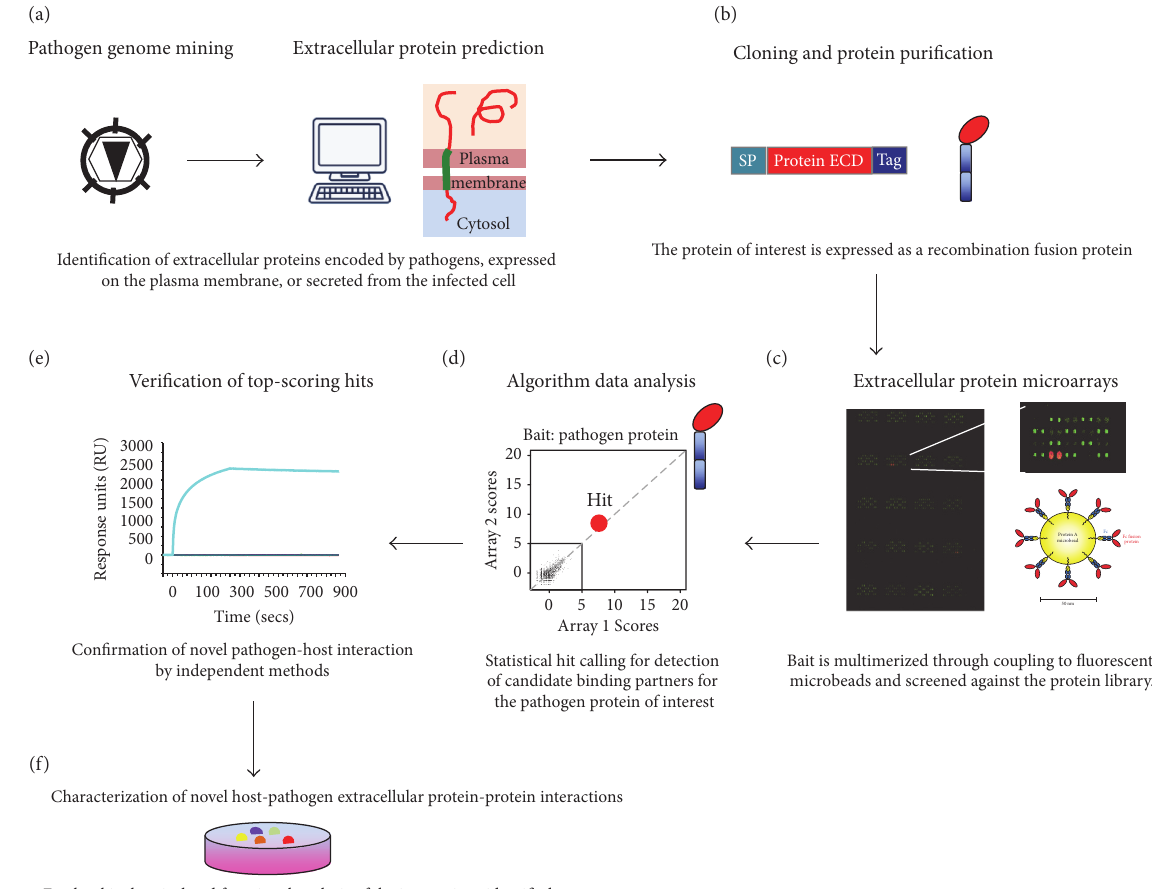
Figure 1: Overview of the application of the protein microarrays technology for extracellular pathogen-host protein-protein interaction discovery. (a) Identification of genes that encode for secreted factors or cell surface-expressed proteins, based on published data or bioinformatics analysis. (b) Cloning, expression, and purification of the pathogen-encoded proteins of interest. The full-length protein (secreted proteins) or the ECD (transmembrane-containing proteins) is fused to a tag for subsequent expression in the heterologous system of choice followed by affinity purification. Mammalian or baculovirus-based systems are preferred to allow for introduction of posttranslational modifications. (c) Screening of the selected pathogen-encoded proteins (baits) against extracellular human protein libraries using protein microarray technologies. Different strategies for bait multimerization have been developed to allow for detection of lower affinity interactions (see text for details). A multimerization strategy based on the coupling of Fc-tagged baits to fluorescent protein A microbeads is shown. Additional microarray-based technologies have been developed to avoid the need for extensive protein purification associated with library generation (see text for details). (d) Algorithm analysis of the protein microarray data. Frequent nonspecific binders in the human library are filtered out, and binding partners for the pathogen protein under study are depicted as high-scoring, intersecting hits. (e) Validation of the interaction between the pathogen-encoded protein of interest and the novel receptor(s) identified in the screens. Experimental validation of the protein-protein interactions may be performed using orthogonal approaches, such surface plasmon resonance, immunoprecipitation, and flow cytometry. (f) Selected binding partners may be further characterized biochemically and functionally to assess the relevance of the novel pathogen-host interactions identified. SP, signal peptide; ECD, extracellular